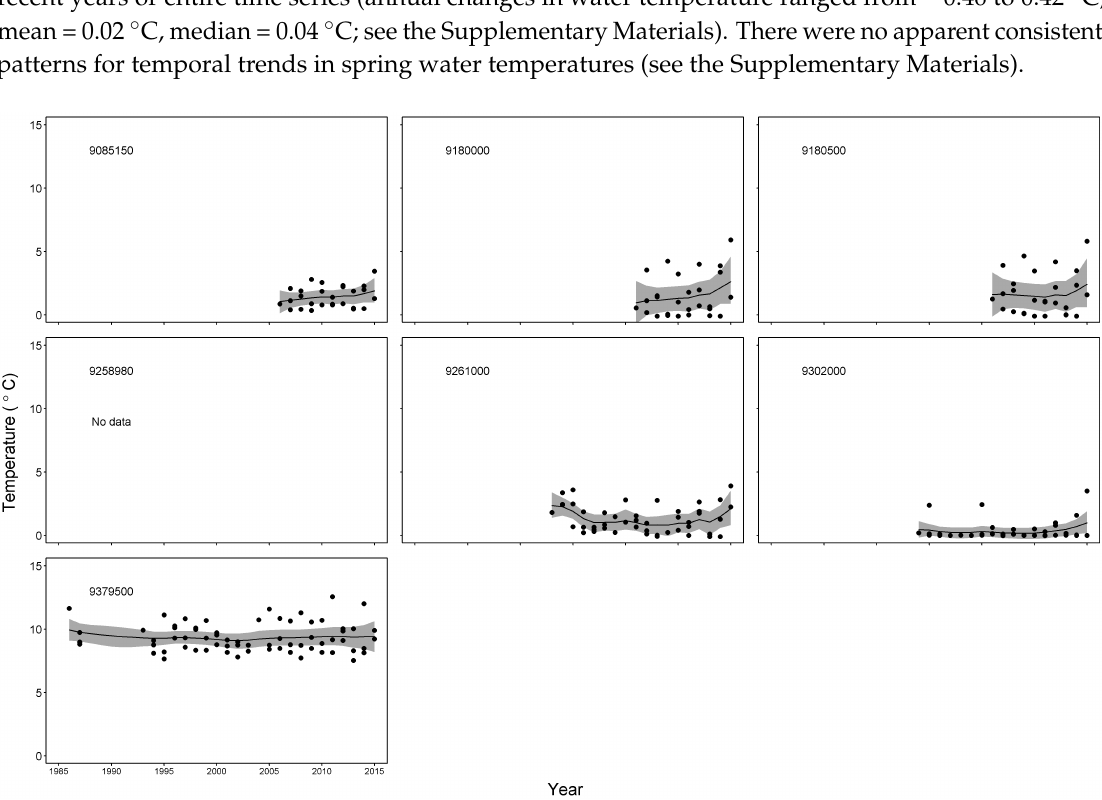
Figure 5. Temporal trends in winter river water temperature for sites located in the Upper Colorado River Basin (see Figure 1 for the site map). Solid circles are observed data; solid lines are posterior mean fitted lines; and shaded areas are 95% credible regions. The numerical codes on each panel correspond to the U.S. Geological Survey gauge